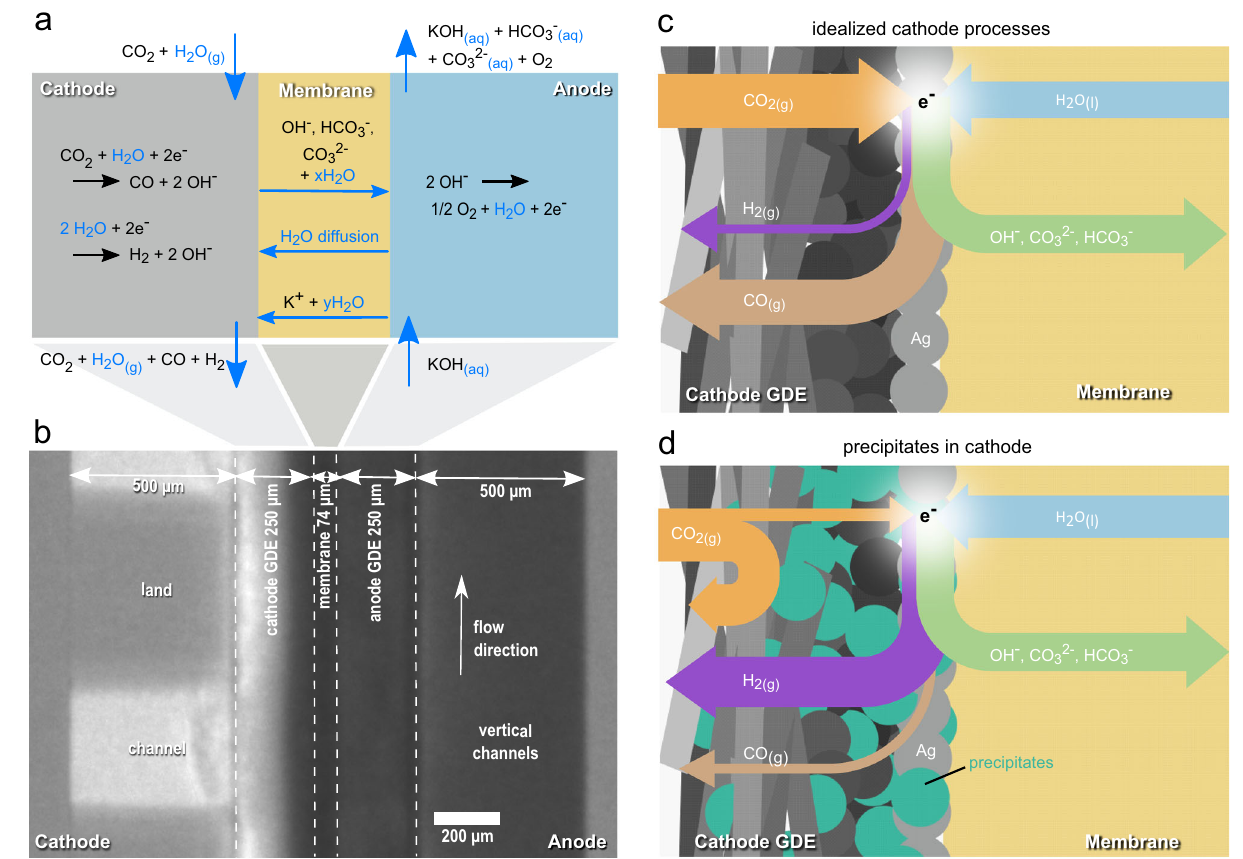
Fig. 1 | Transport processes and cell components. a water management high- lighted in schematic of reactions and transport processes during operation. b enlarged section of a normalized neutron radiographic image of the CO